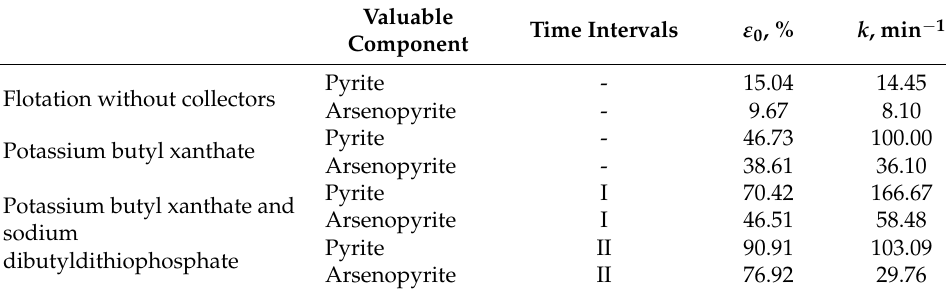
Table 2. The kinetics study results of flotation